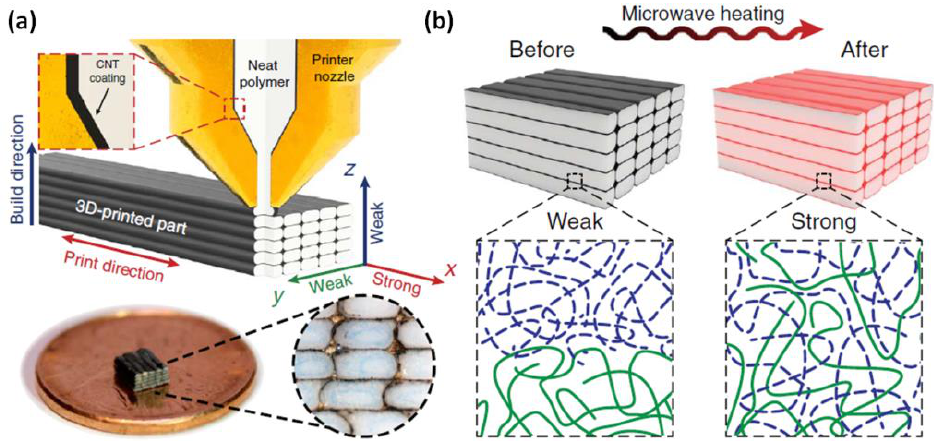
(thickness of 5 mm) containing, 0.1 wt. % CNTs as finished part; ( b ) Circuit-like structure built on an insulating base (PEGDA:PEGMEMA 1:1.5 wt/wt with brilliant green as colorant) with suspended elements containing 0.1 wt. % CNTs (30 × 50 mm. Copyright © 2017, with permission from Elsevier [77].